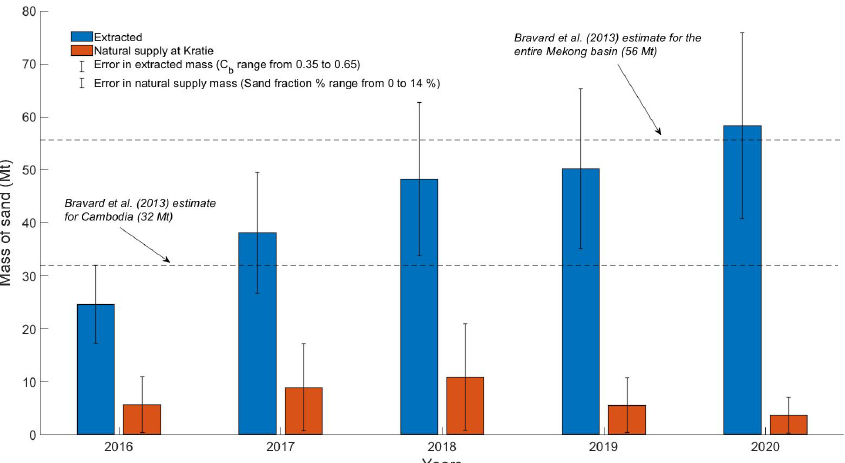
Figure 4. Volume of sand extracted each year for the period 2016 to 2020 (blue bars) for the study reach in Cambodia between Kampong Cham and the Vietnamese border. Error bars represent annual volumes calculated under varying levels of the compaction factor, C b , from 0.35 to 0.65 (see Sect. 2.3 for details). Orange bars represent the annual volume of sand supply transported naturally by riverine processes at Kratie, Cambodia. Error bars represent annual volumes calculated under varying levels of the proportion of suspended-sediment flux that is sand (ranging from 0% to 14%). The mass of sand extracted from Cambodia in 2013 as estimated by Bravard et al. (2013) is demarked by the dash–dot line at 32Mt; similarly the estimated mass of sand extracted from the entire Mekong Basin in 2013 is demarked by the dashed line